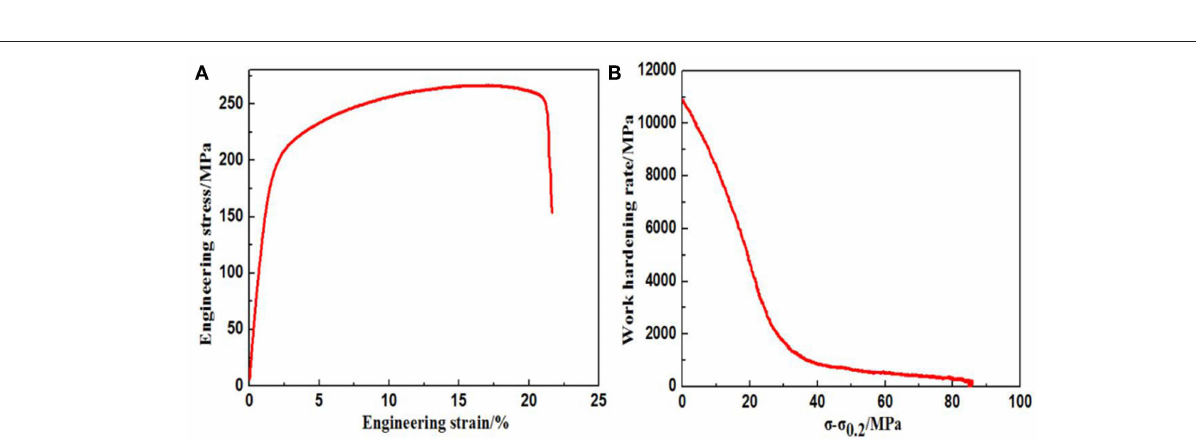
FIGURE 6 | The tensile properties of the extruded dilute TMX-1.0 alloy: (A) typical ambient-temperature tensile stress-strain curve, and (B) the working hardening response.